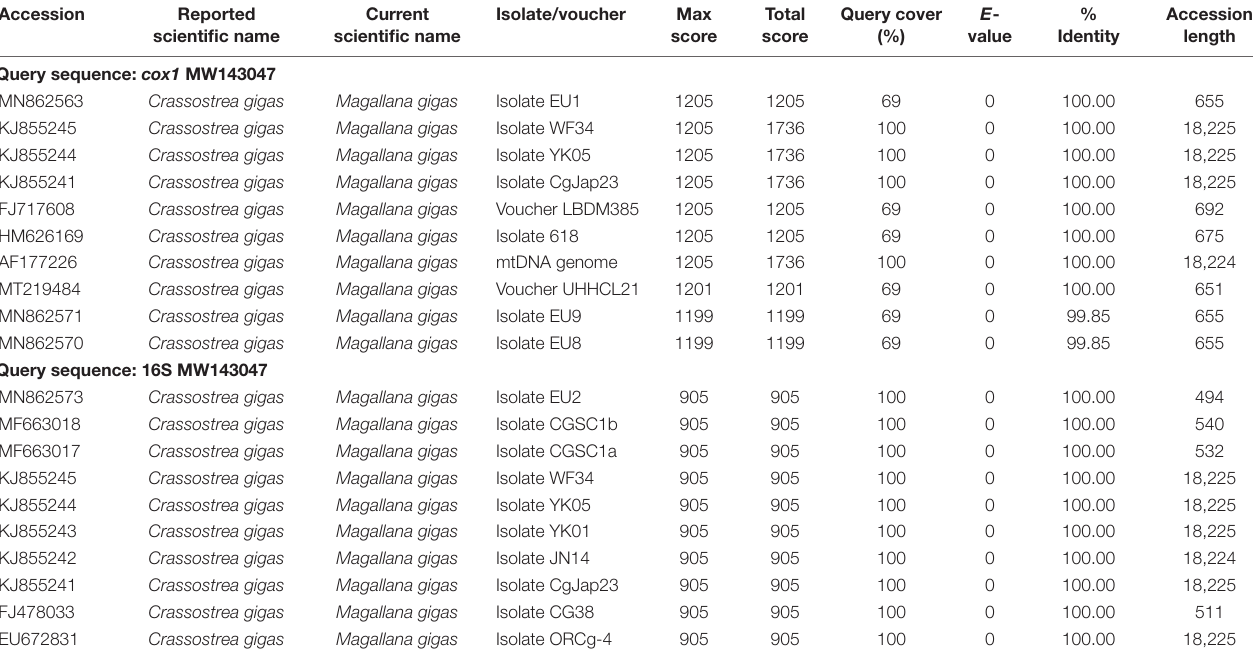
TABLE 1 | Top 10 best hits of BLAST results using as query the sequences of the barcoding fragments cox1 (above) and 16S rRNA (below) extracted from the complete mitochondrial genome